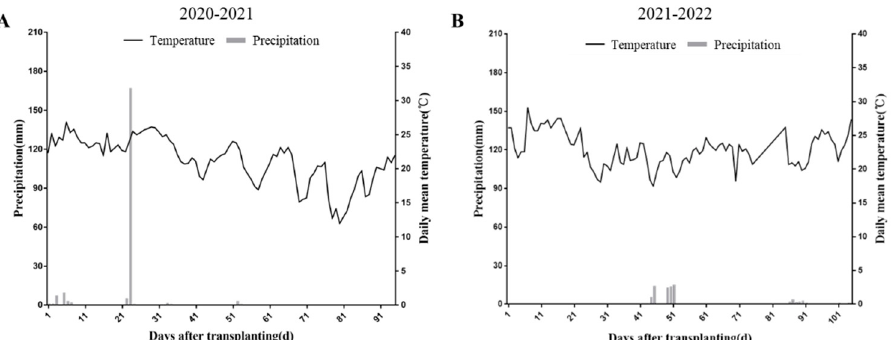
Figure 1. Daily precipitation and mean air temperature during cherry tomato growth seasons in 2020–2021 ( A ) and 2021–2022 ( B ). 2020–2021 ( A ) and 2021–2022 ( B